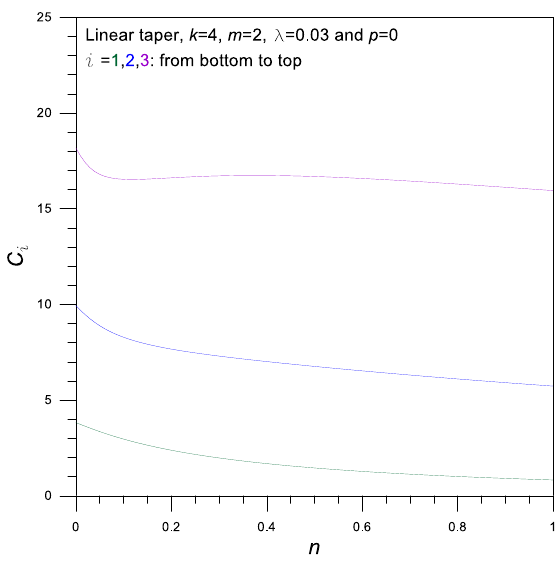
Figure 4. Frequency parameter 𝐶 𝑖 versus taper ratio 𝑛 curves.